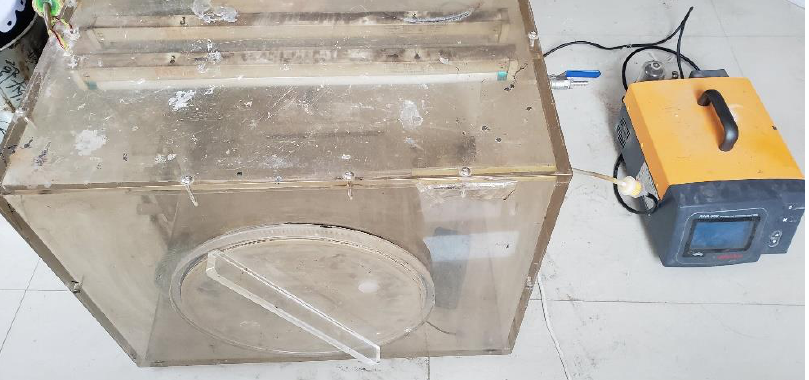
Figure 1. The exhaust purification system [29].